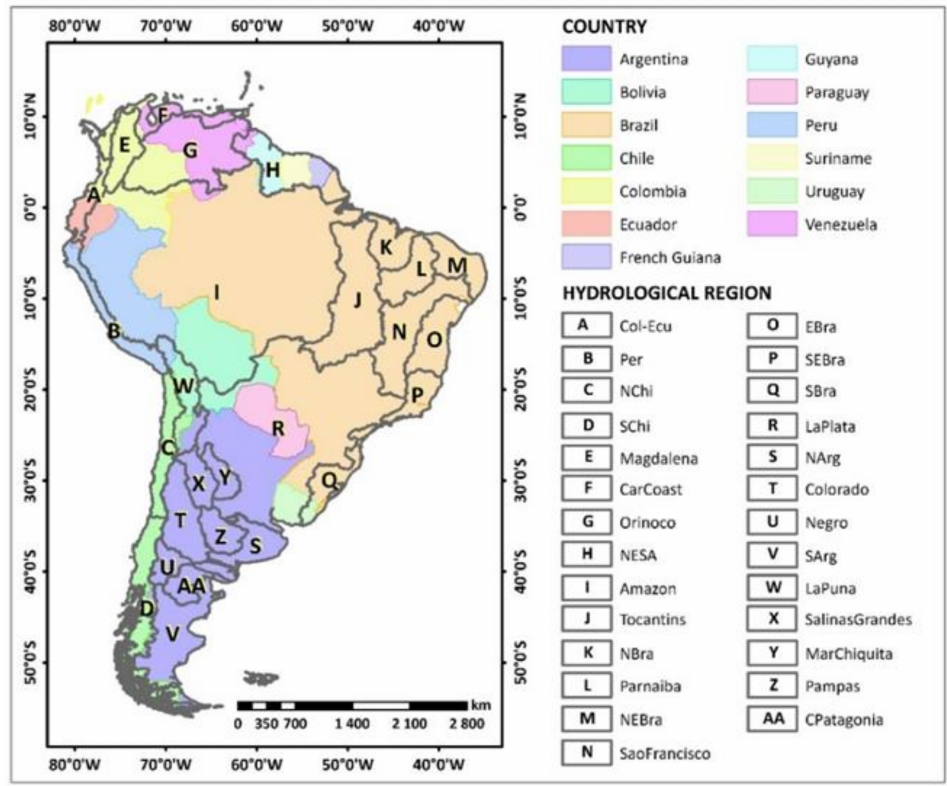
Figure 1. Area of study. The 13 countries considered for this study are represented with colors. The 27 hydrological regions defined by FAO [56] are represented with